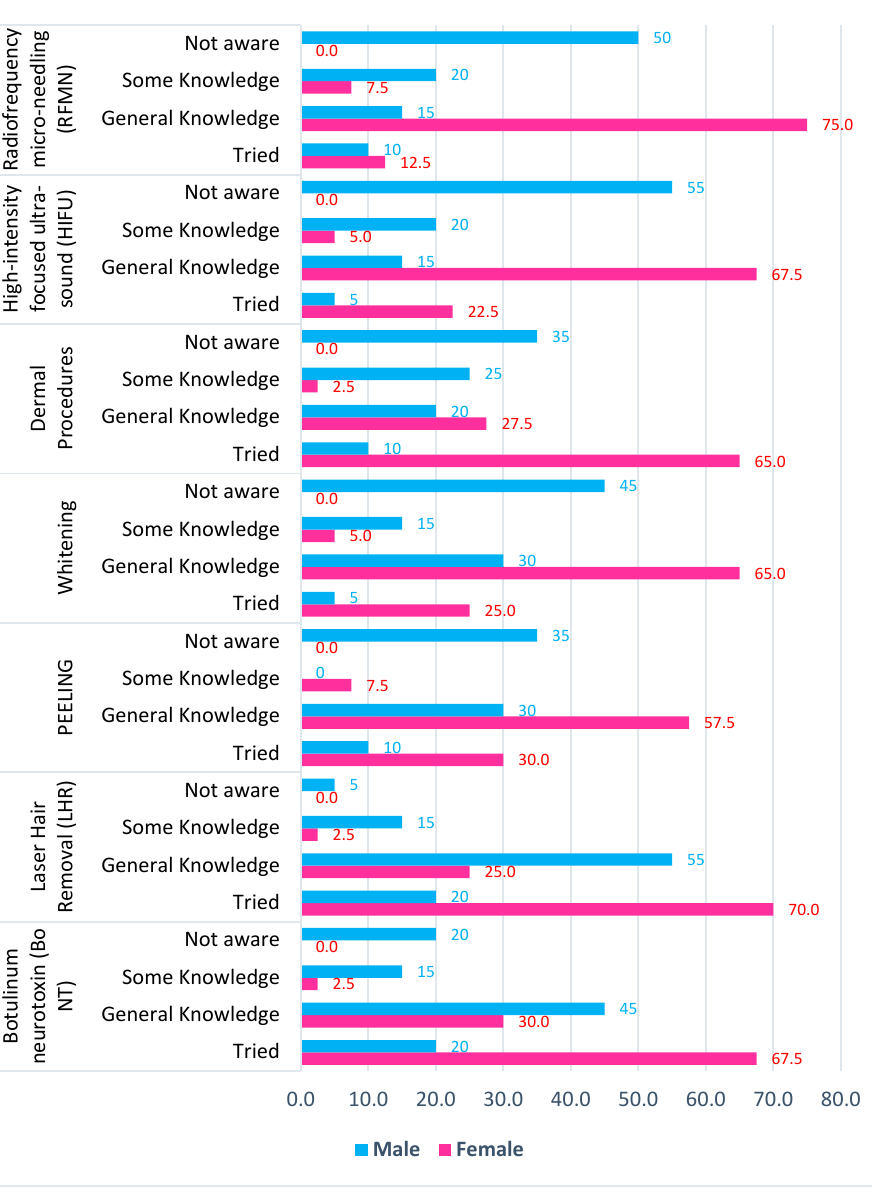
Figure 2. Depth of knowledge about cosmetic procedures prior to the survey.